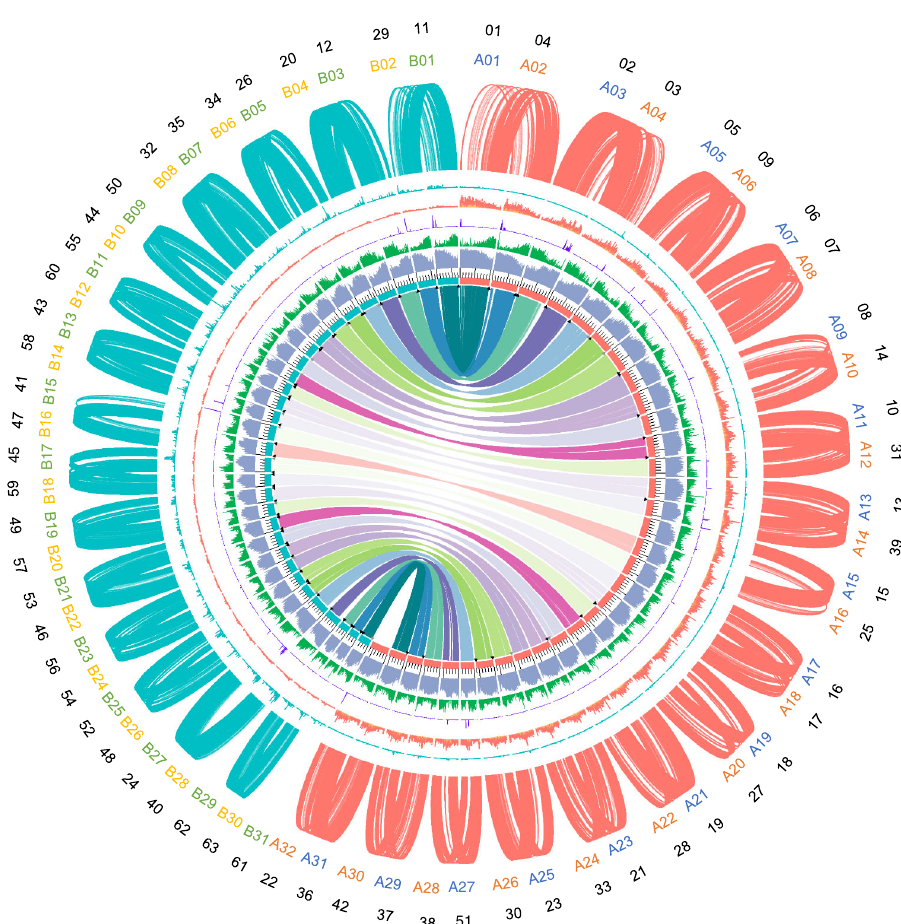
Fig. 1 Overview of the patchouli genome. The tracks from the inner to outer regions of the circle indicate the chromosomes, density of repeat sequences, coding genes, noncoding genes, and density of enriched 13-mer sequences in the subgenomes A and B, respectively. The links inside the circle show intersubgenome syntenic gene pairs, and the links outside the circle show intrasubgenome syntenic gene pairs. The triangles on chromosomes indicate telomere regions. The regions locate at the exactly start or end of chromosomes are shown in black, while the others are shown in gray. All the density tracks are calculated by the base coverage in continuous 100 kb windows. The density ranges for repeat sequences and genes are both 0 to 1, those for noncoding genes are 0 to 0.40, those for subgenome A speci fi c 13-mer sequences are 0 to 0.26, and those for subgenome B speci fi c 13-mer sequences are 0 to 0.06. Chromosomes, enriched 13-mers, and syntenic gene pairs between the intrasubgenomes are colored orange for subgenome A and cyan for subgenome B. The numbers in the outermost circle are original chromosome IDs, in the penultimate circle are updated subgenome chromosome IDs; they are colored according to the mini-subgenomes they belong to. The pre fi x “ Chr ” for original chromosome IDs and the pre fi x “ I ” and “ II ” for updated subgenome chromosome IDs were